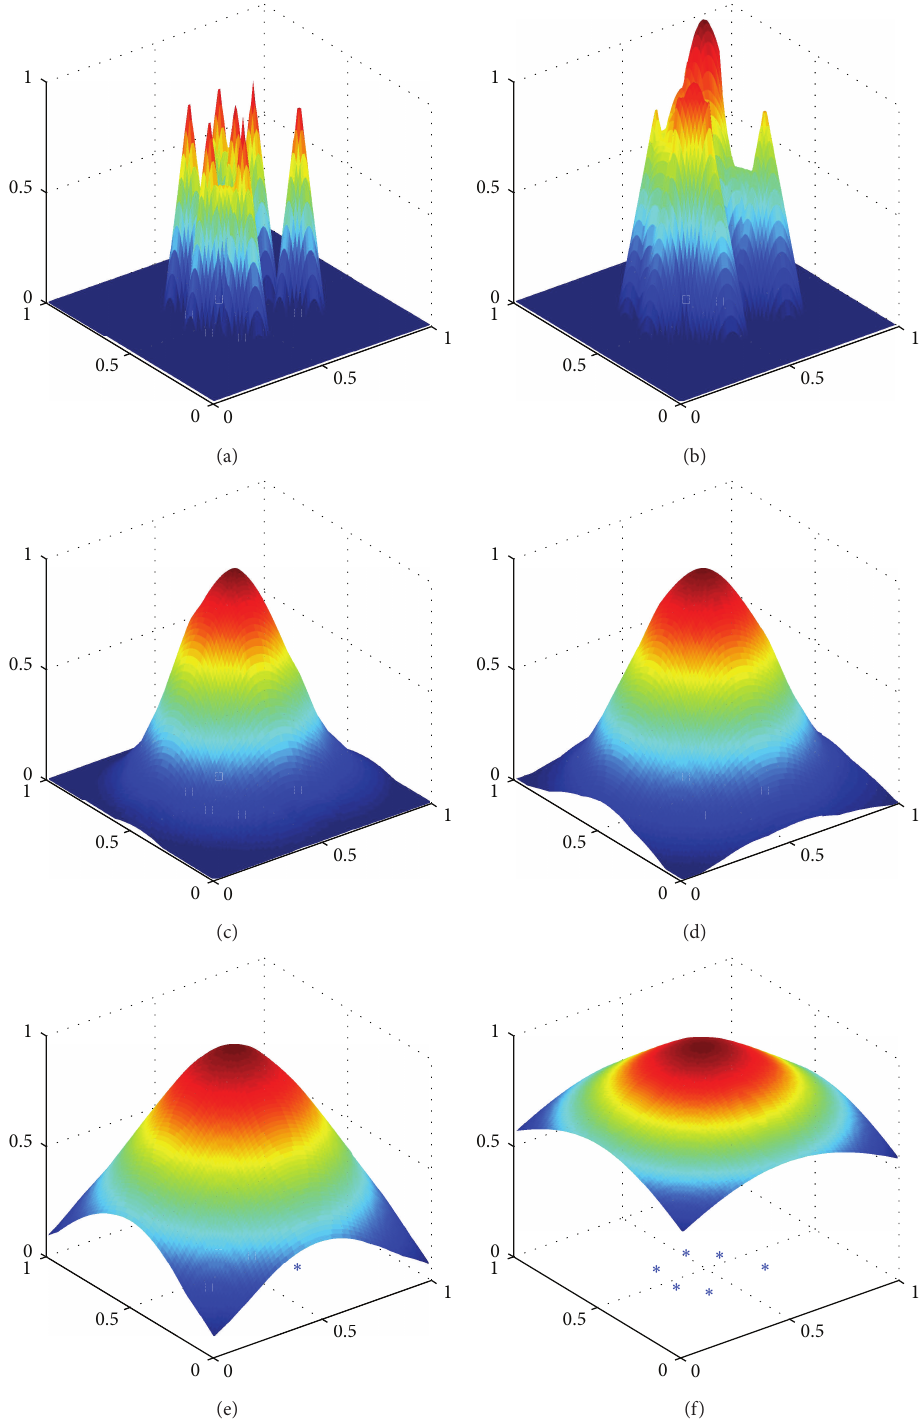
Figure 5: 2D cone-based MFs with different values of 𝛾 : (a) 𝛾 = 15 ; (b) 𝛾 = 10 ; (c) 𝛾 = 4 ; (d) 𝛾 = 3 ; (e) 𝛾 = 2 ; (f) 𝛾 = 1 . The patterns determining the convex hull are plotted as asterisks in the data